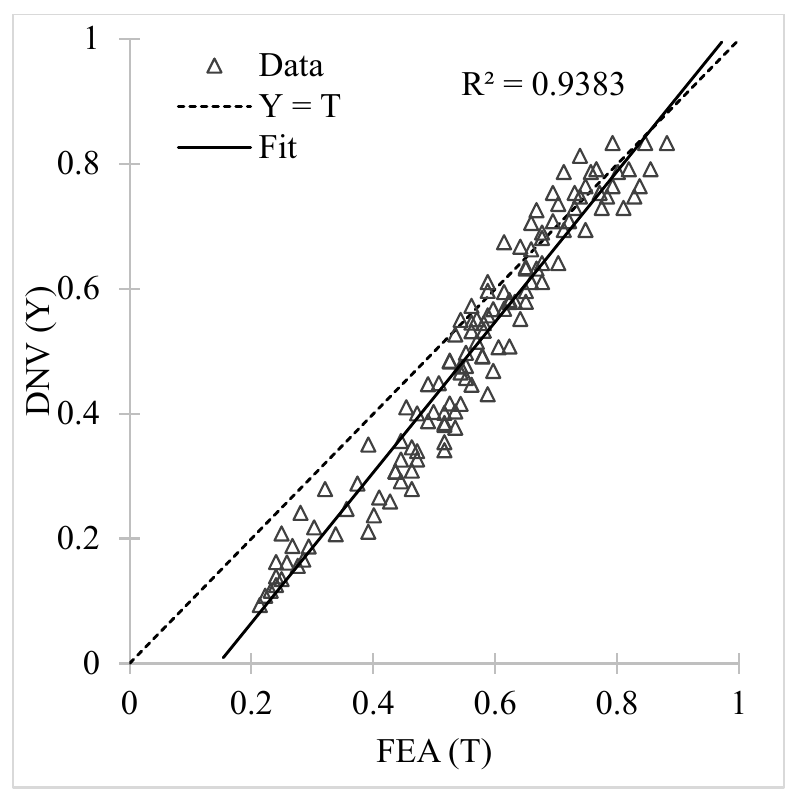
Figure 15 . Regression plot of normalized failure pressure predicted using DNV method against FEA results.